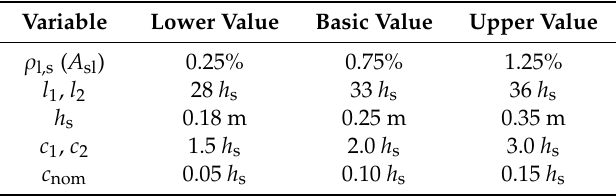
Table 1. Values of the considered independent variables.